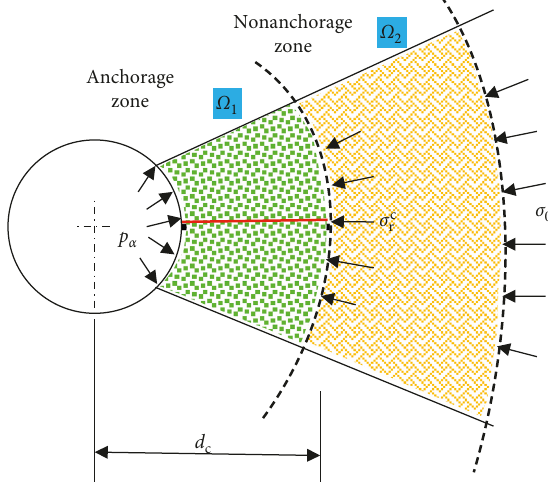
Figure 3: Analysis model of anchorage